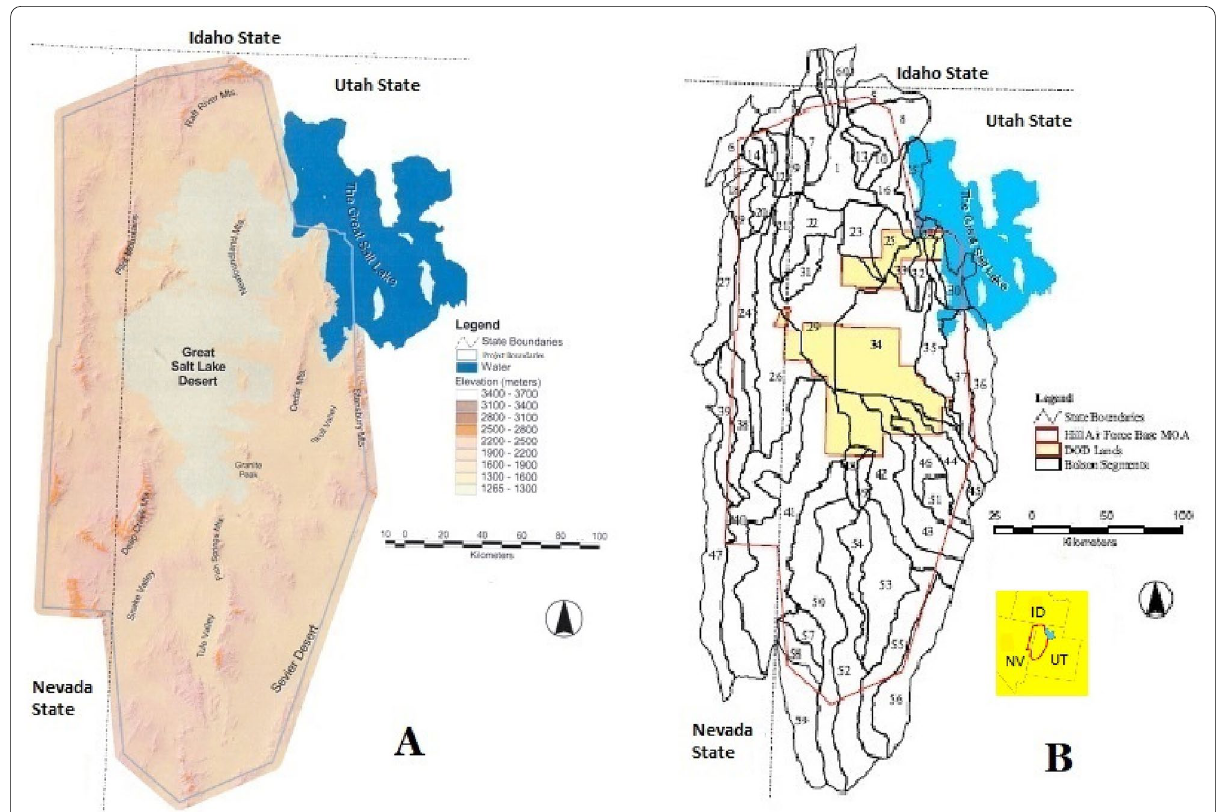
Table.2 ECOMAP’s ecosystem classification of Western Utah, the United States